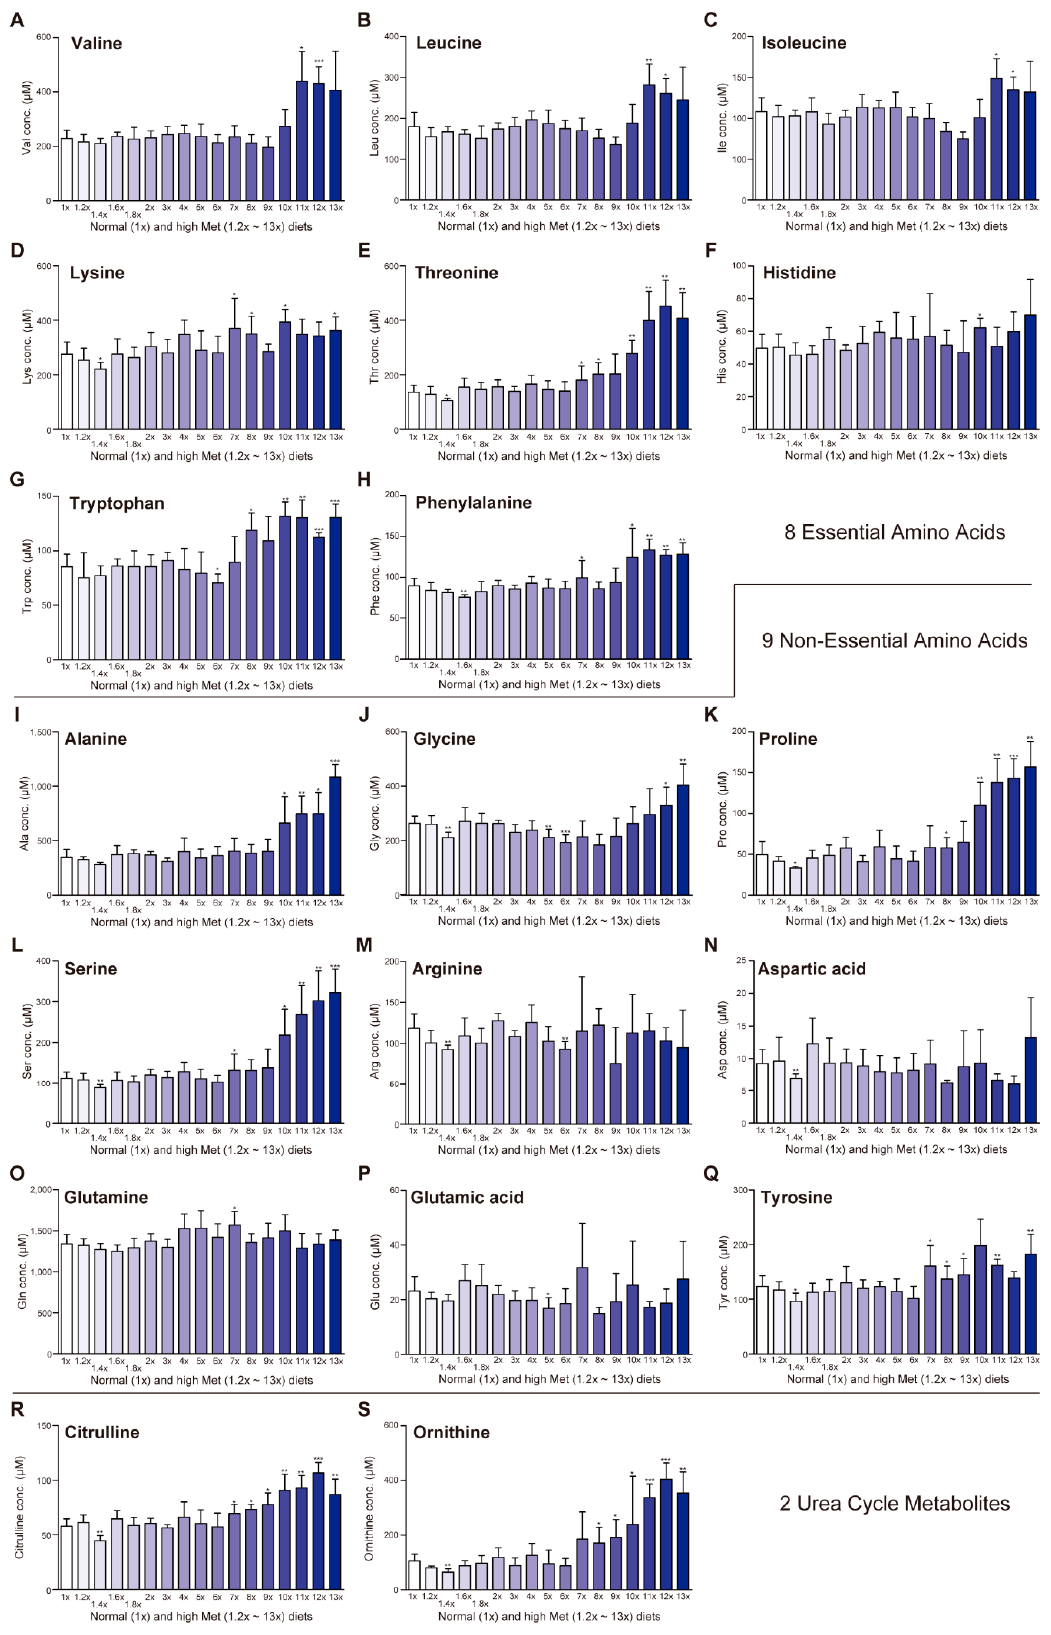
Figure 3. Impact of one-week high-methionine (Met) diet on serum amino acid levels. Adult C57BL/6J male mice were ad libitum fed a standard CE-2 rodent diet (0.440% Met) until 8–9 weeks of age